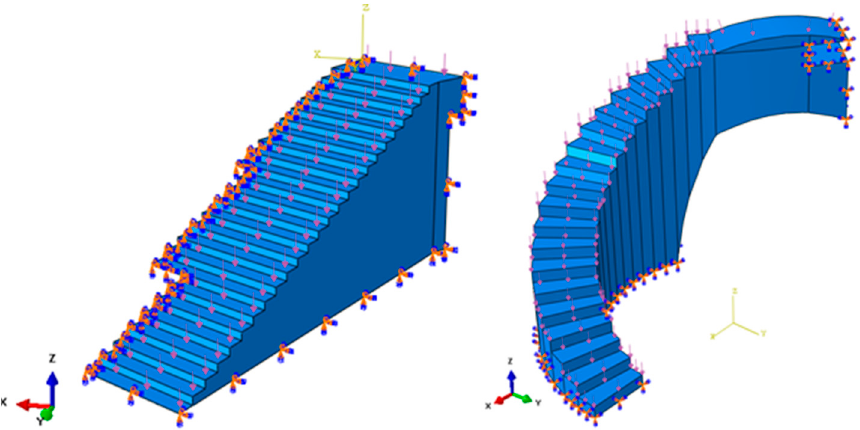
Figure 14. Load scenario and the boundary conditions associated with the bounding boxes B 1 ( left ) and B 2 ( right ).